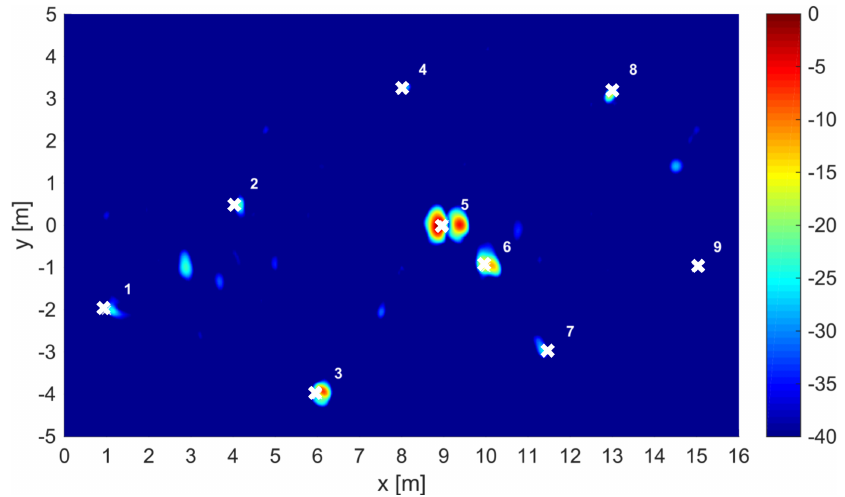
Figure 10. MF image of Figure 5 after ACF based enhancement.